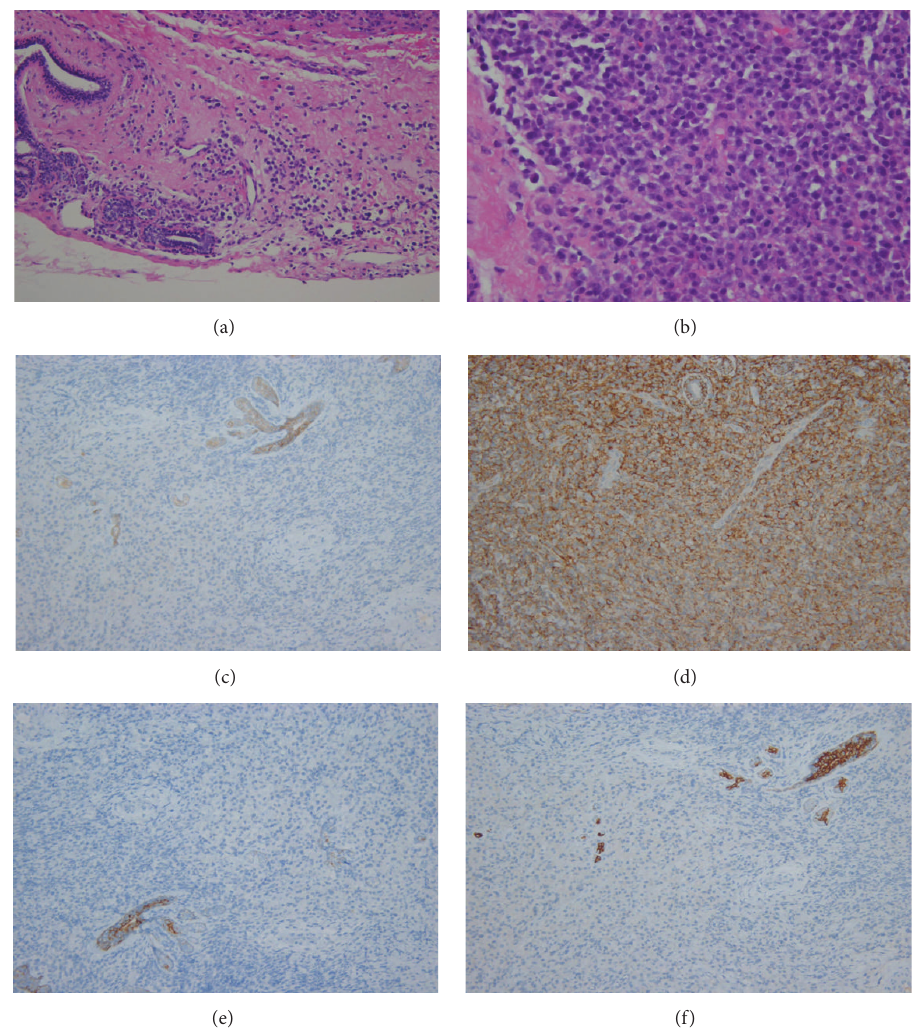
Figure 2: Histopathological analysis ((a) HE × 200) of left breast mass shows infiltration of plasmacytoid cells around the ductal breast tissue. The plasmacytoid cells are eccentrically located with slightly enlarged nuclei compared to mature plasma cells ((b) HE × 400). Photomicro- graphs show a positive reaction for CD 138 ((c) × 200), indicating plasma cell origin, and positive reactions for E-cadherin ((d) × 200), CK5/6 ((e) × 200), and CK7 ((f) × 200) in the entrapped breast ductal tissue, but negative in infiltrated cells, suggesting a nonepithelial